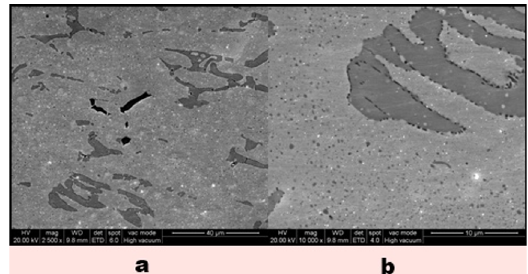
Figure 5. CuNiSiCr alloy annealed at 900 °C for 7.5 hours oven- cooled and forged (a) overview, (b) zoom of the precipitate